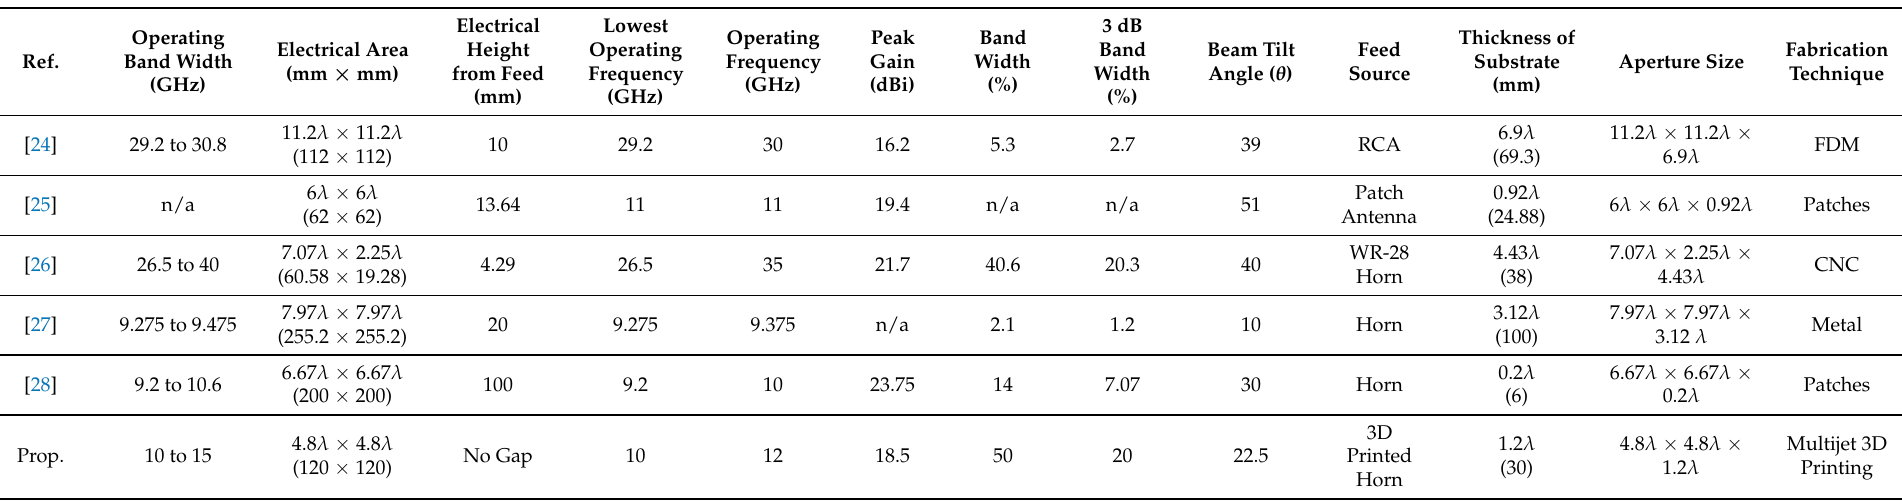
Table 1. Comparison of proposed beam tilting prototype against the other designed antenna